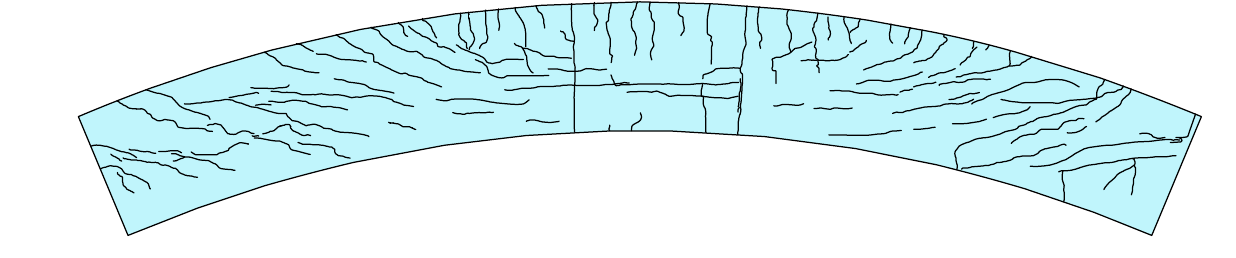
Figure 7. Crack profile of CCB-3.